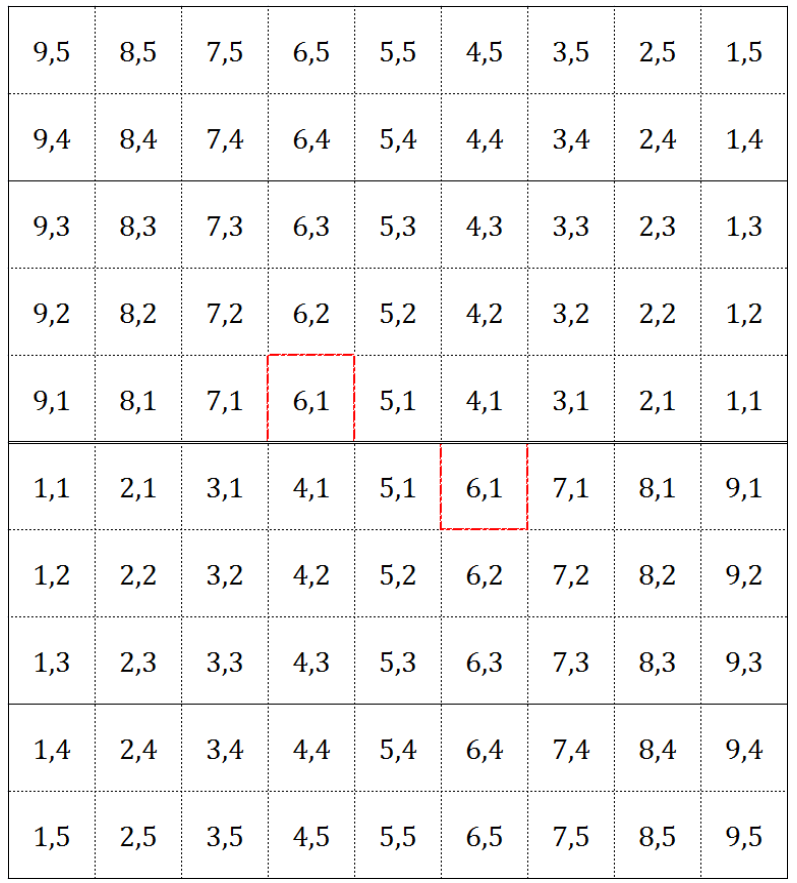
Figure 1. Latitude and depth (respectively) of the setter, and ideal setting zone (in red).